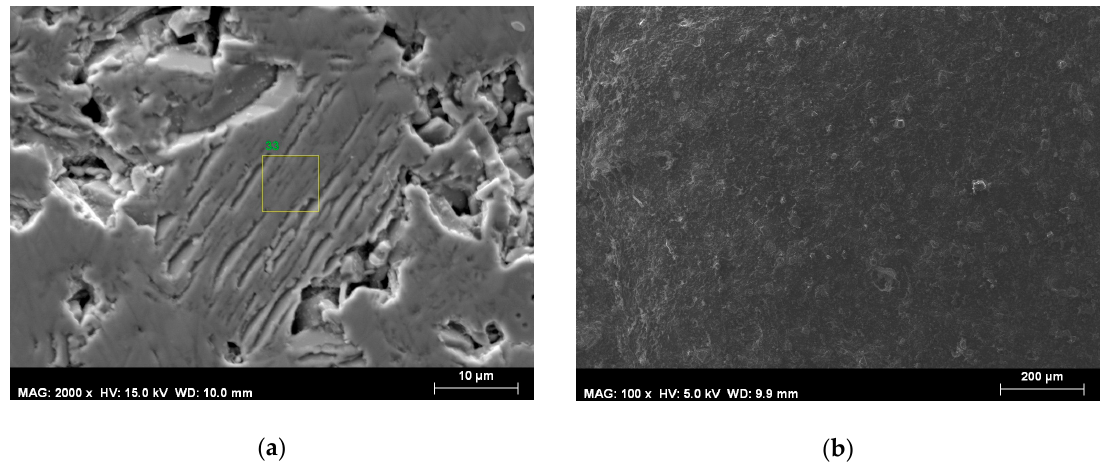
Figure 5. SEM image of ( a ) cross-section of bulk Sr 3 Co 2 Fe 24 O 41 and ( b ) cross-section of composite sample B.